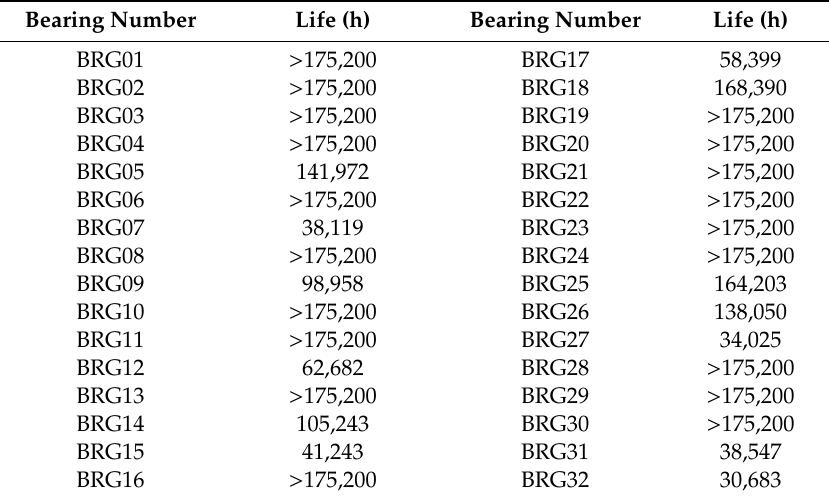
Table A3. Life of bearings for test rig